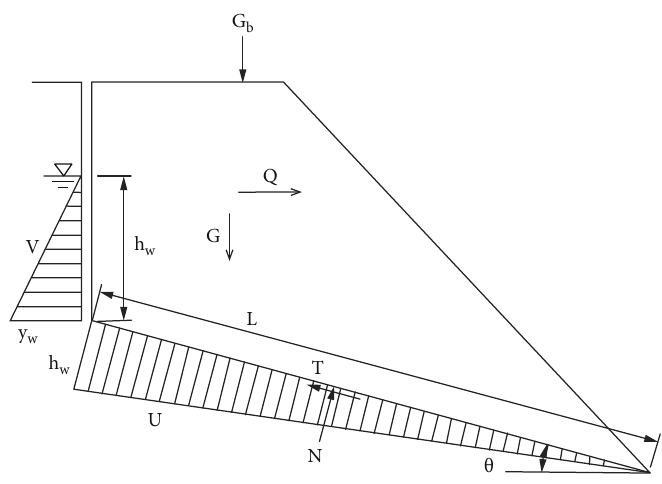
Figure 11: Structural plane stability calculation